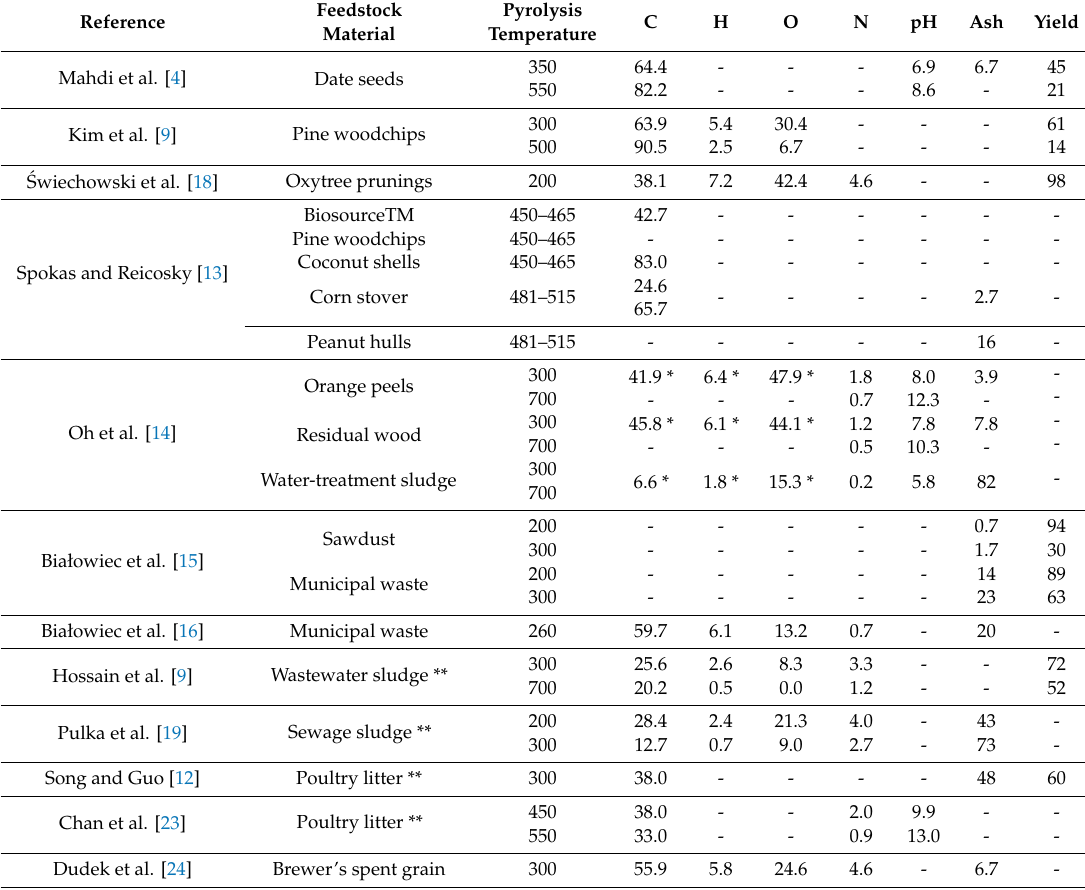
Table 1. Summary of selected data on biochar